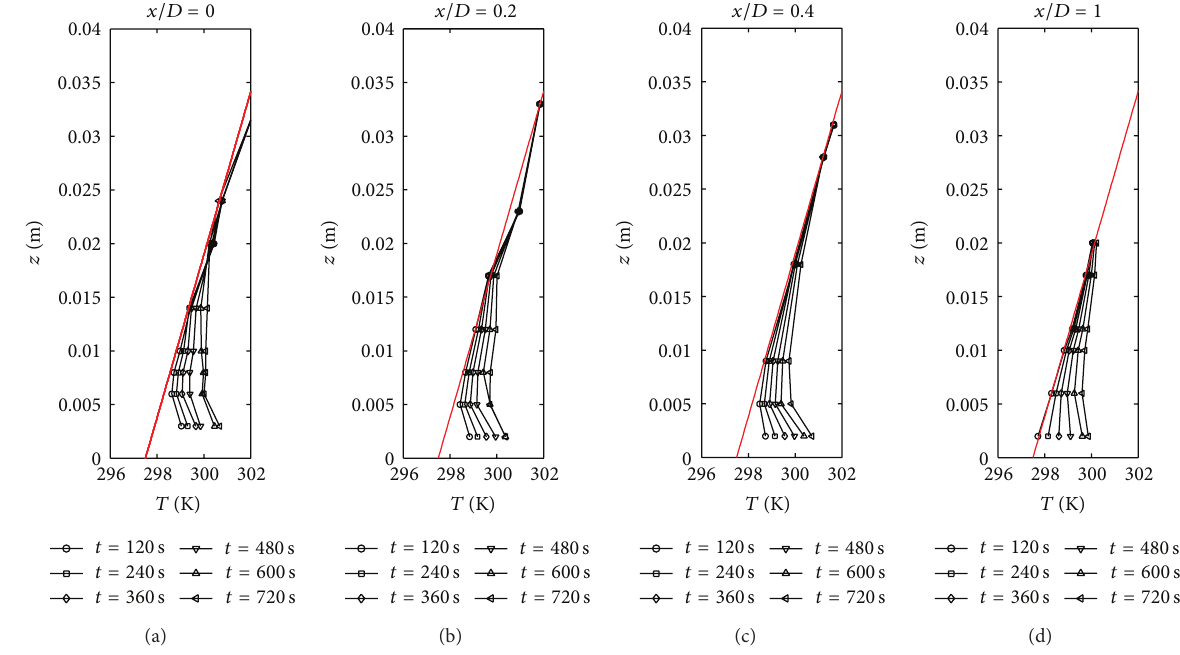
Figure 32: Mean temperature profiles as a function of the distance from the UHI center for the diurnal UHI